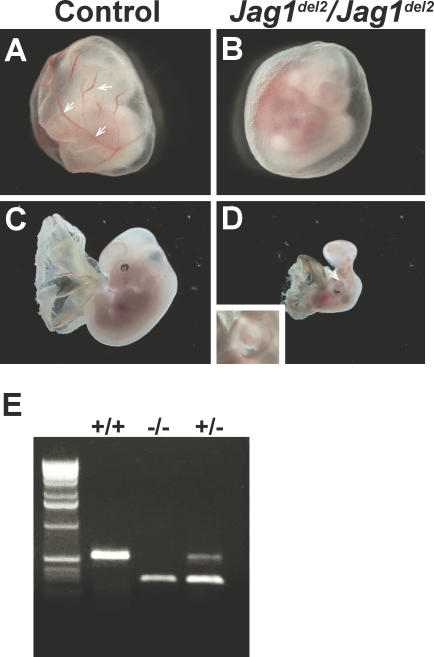

Jag1del2/Jag1del2 Embryos Exhibit Vascular Defects and Lethality Consistent with Loss of JAG1 Function(A and B) E10.5 embryos demonstrating the loss of large blood vessels (white arrows in [A]) in the Jag1del2/Jag1del2 yolk sacs (B) similar to other Jag1 loss-of-function mutants. (C and D) E11 embryos demonstrating a small, necrotic Jag1del2/Jag1del2 embryo (D). White arrow in (D) indicates an enlarged pericardial sac (enlarged, inset), which is frequently observed in mutants exhibiting cardiovascular defects. RT-PCR results using primers that span exon 4 using RNA extracted from E10.5 control (+) and ZP3-Cre deleted embryos (−) (E). The upper band (541 bp) indicates that the wild-type allele is present. The lower bands (286 bp) indicates the Jag1del2 mutant allele that does not contain exon 4.